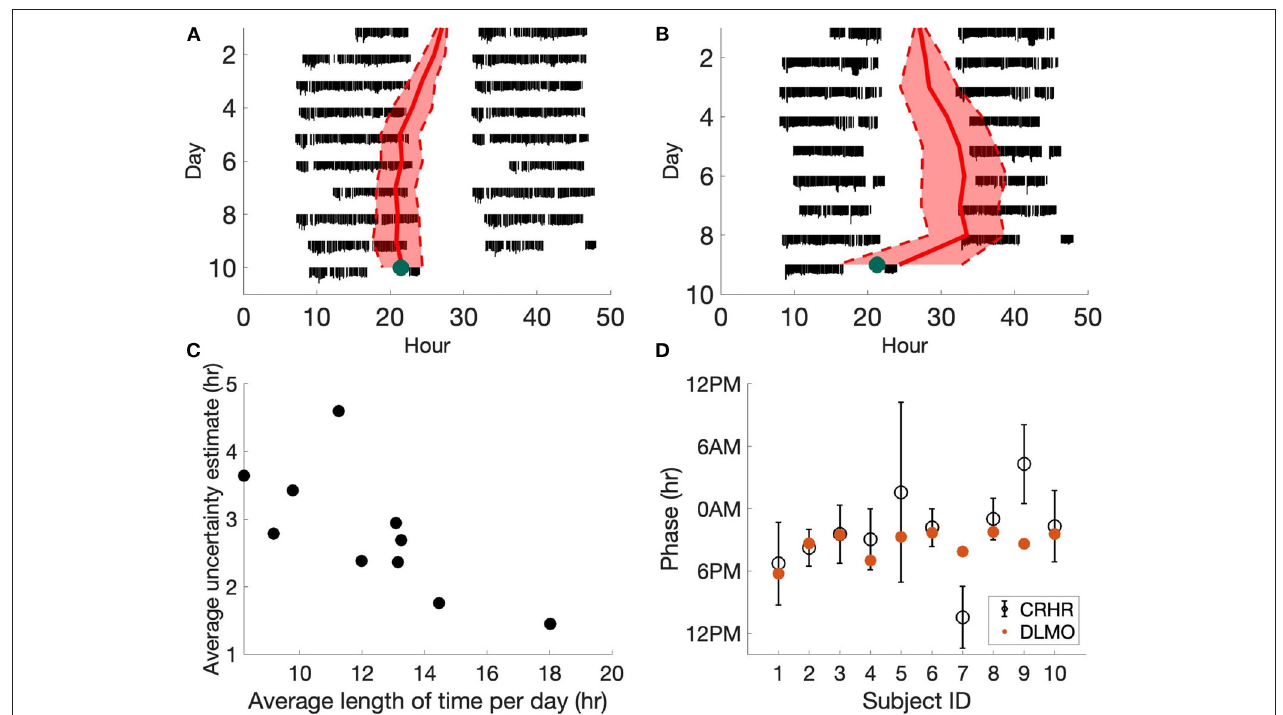
FIGURE 1 | Heart rate phase and DLMO. (A,B) Actograms for two subjects generated from Apple Watch data. Estimated CRHR phase (red, with 80% confidence bands) is overlaid on daily heart rate patterns (black). Laboratory DLMO measurement is marked by the green dot. The subject in (A) wore the device for longer during the day than the subject in (B) which led to more accurate circadian phase measurements. (C) For each subject, we computed the average length of time wearing the device per day. We can see that the uncertainty estimates of the phase of the CRHR tend to decrease as the user wears the watch for longer periods of the day. (D) Estimated CRHR phase (black circle, with 80% confidence bands) are plotted for all ten subjects, where red dots denote laboratory DLMO measurements. CRHR phases in (A,B,D) were shifted by − 4.4h to account for the mean difference between DLMO and CRHR.